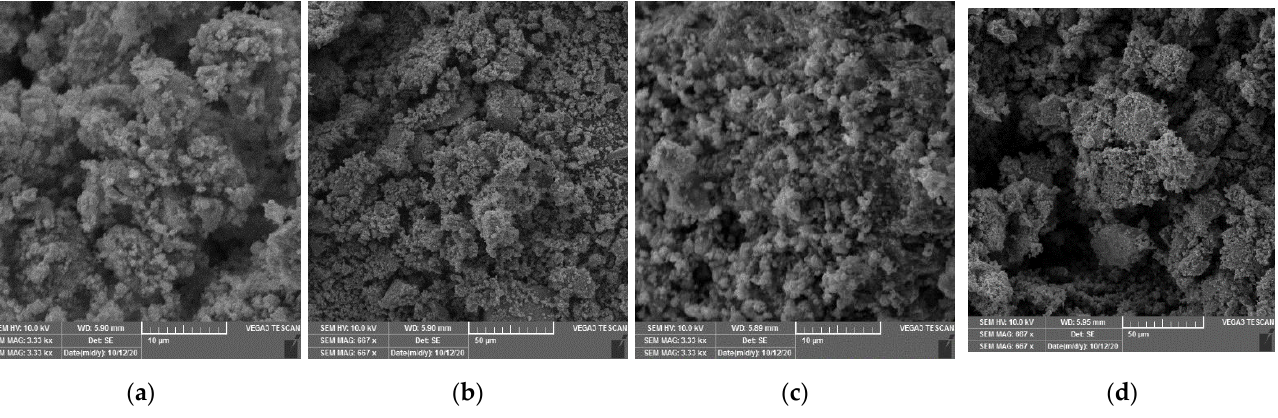
Figure 4. ( a , b ) SEM images of N/TiO 2 0. ( c , d ) SEM images of N/TiO 2 12.